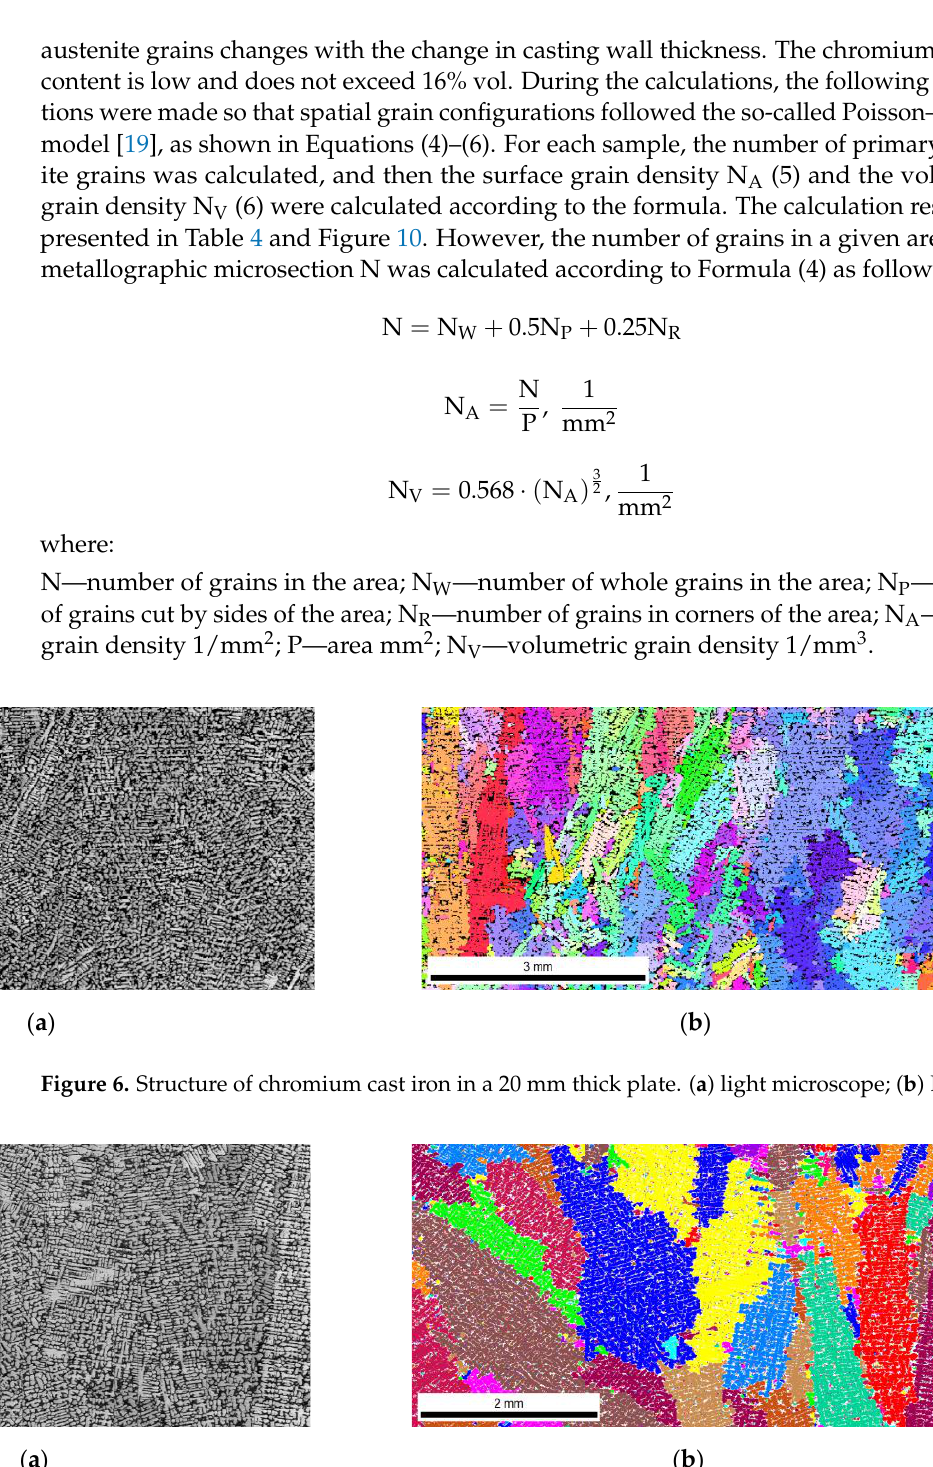
Figure 8. Structure of chromium cast iron in a 40 mm thick plate. ( a ) light microscope; ( b ) EBSD. Figure 9. Phase and grain orientation scale. Table 4. Data and results for calculating numbers of N A and N V grains. Sample